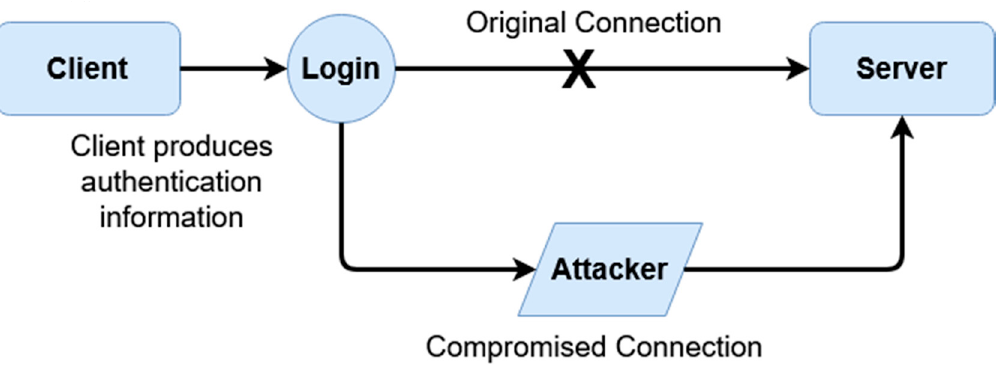
Figure 8. MiTM attack under a normal authentication system.